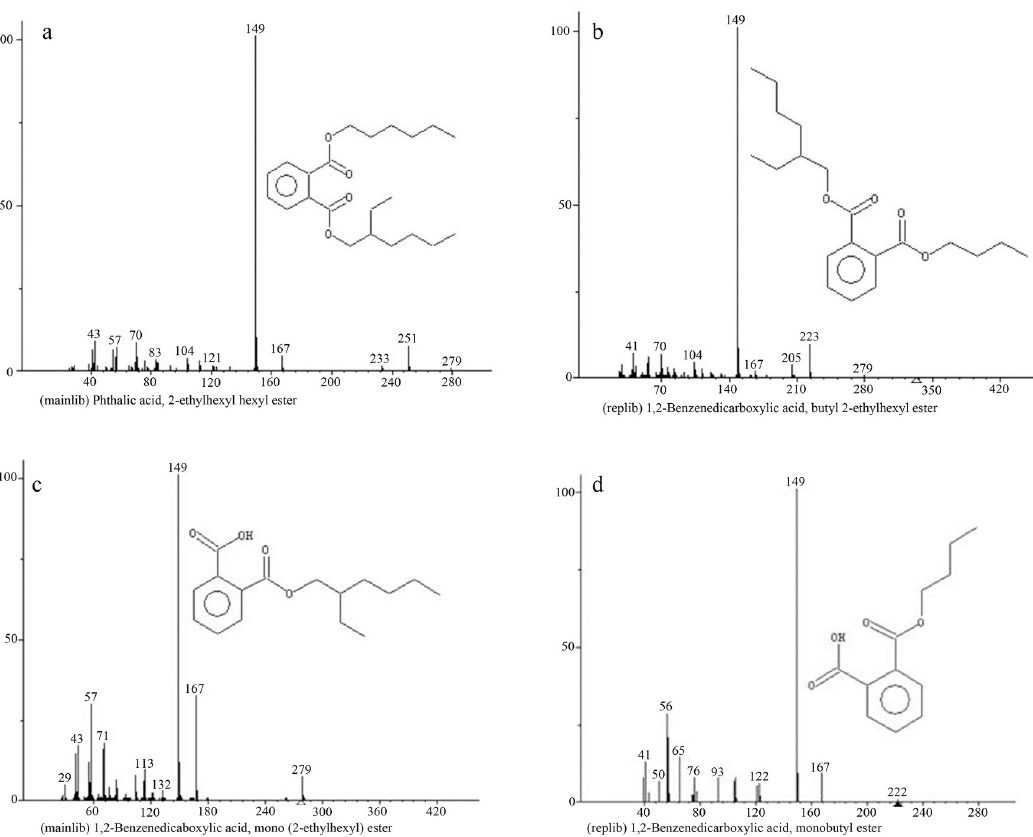
Fig 6. MS spectra of the intermediates of DEHP by LF. (a) 2-ethylhexyl pentyl phthalate (EHPP) (b) butyl (2-ethylhexyl) phthalate (BEHP) (c) mono-ethylhexyl phthalate (MEHP) (d) mono-butyl phthalate (MBP).